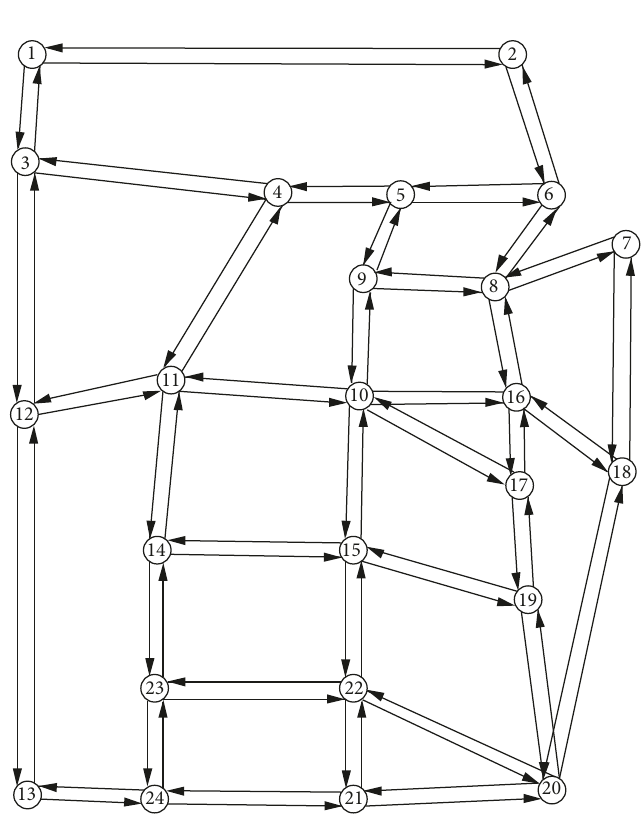
Figure 13: Sioux Falls